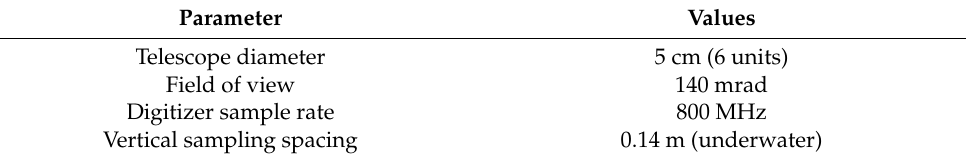
Table 2. Parameters of the LiDAR